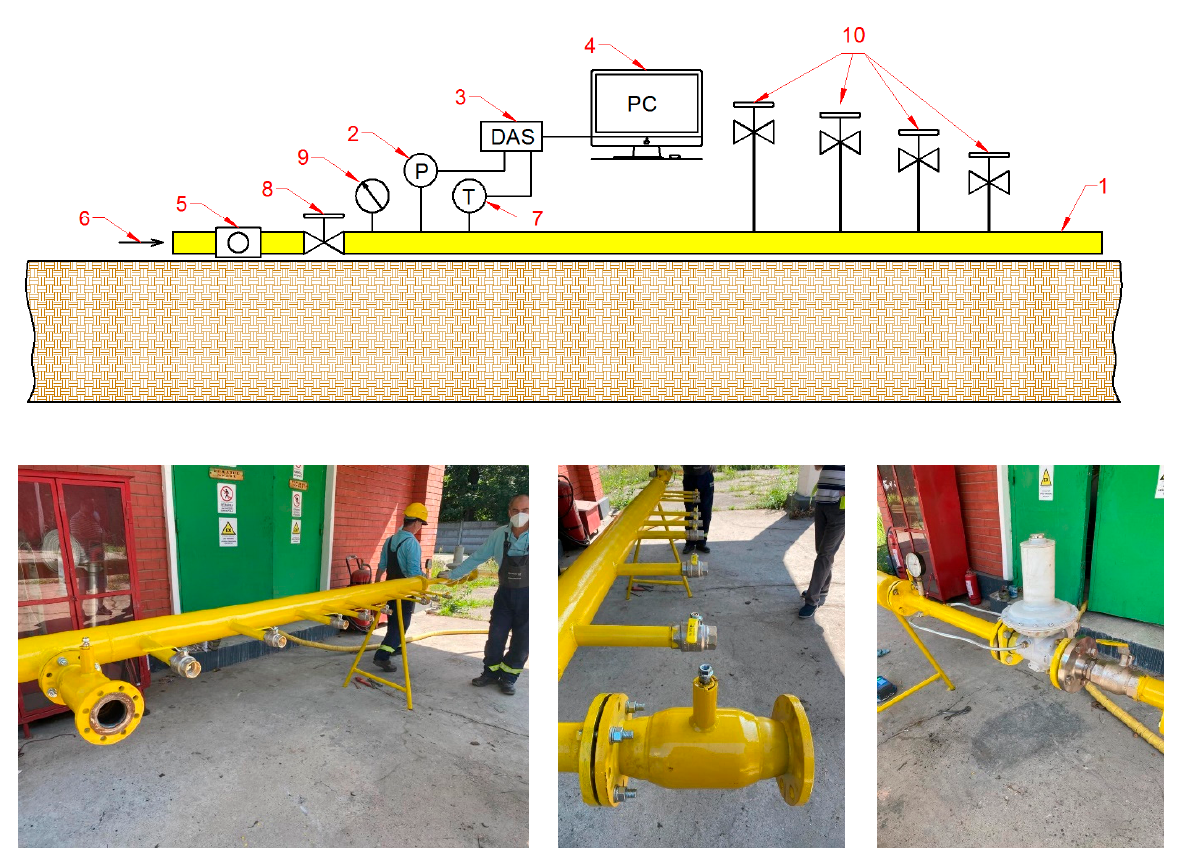
Figure 5. Experimental stand structure for losses due to ill-fitting (1—pipe coupon with a minimum diameter of 150 mm and a length of 6 m, 2—pressure transducer, 3—data acquisition system, 4—pressure-time recording system, usually with PC, 5—flow meter with rotating pistons, 6—gas source, 7—temperature transducer, 8—faucet, 9—pressure gauge, 10—various types of equipment) (source: authors based on the real analysed equipment).